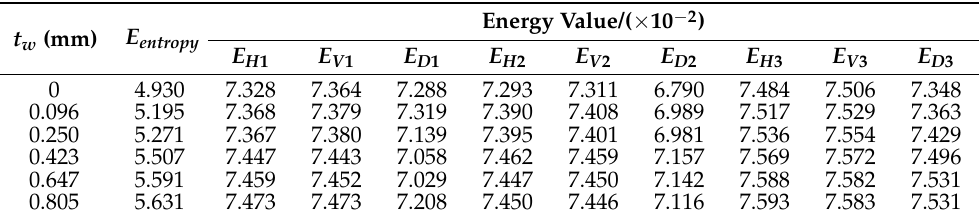
Table 1. Corresponding energy value of sub-images and information entropy for various corrosion depths.